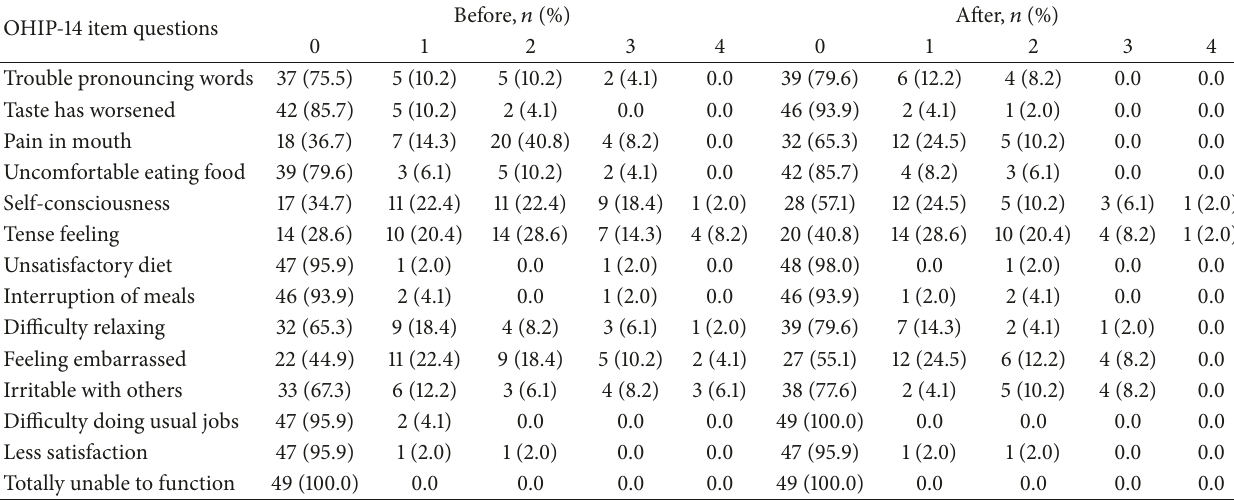
Table 2: Distribution of responses to OHIP-14 item scores for all participants.